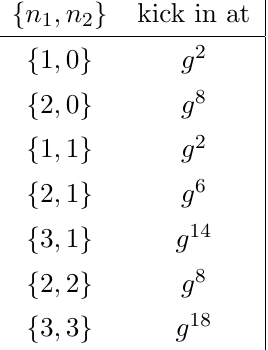
n 1 = 1 ; n 2 = 0 and n 1 = 1 ; n 2 = 1 f g f g